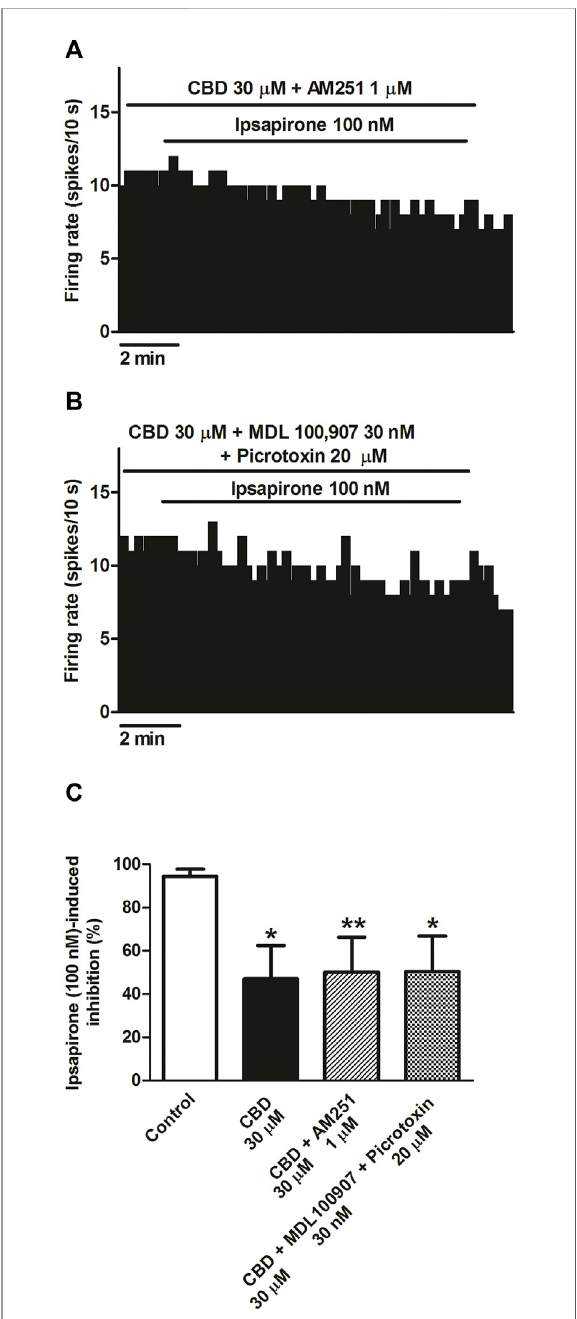
FIGURE 3 Mechanisms involved in the blockade by CBD of the ipsapirone-induced inhibitory effect on DRN 5-HT cells. (A,B) Representative examples of fi ring rate recordings from two DRN 5-HT neurons, which represent the effect of CBD on the ipsapirone (100 nM)-induced inhibition in the presence of the CB 1 receptor antagonist AM251 (1 μ M) (A) or in the presence of the GABA A receptor antagonist picrotoxin (20 μ M) and the 5-HT 2A receptor antagonist MDL100907 (30 nM) (B) . (C) Bar histograms showing the percentage of inhibition from the basal fi ring rate (mean ± SEM) induced by ipsapirone (100 nM) in the absence ( n = 13) and presence of CBD (30 μ M, n = 10), CBD (30 μ M) + AM251 (1 µM)( n =9)andCBD(30 μ M)+MDL100907(30